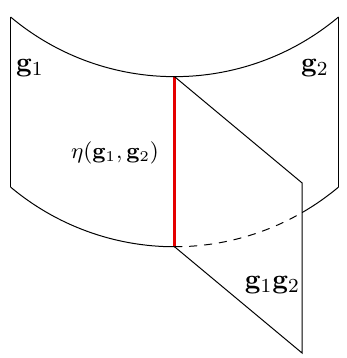
Figure 5 . A junction (in red) where three codimension-one 0-form symmetry defects of type g 1 ; g 2 ; g 1 g 2 2 G meet in codimension two, with one additional dimension suppressed in the (cid:12)gure. The junction can be modi(cid:12)ed by inserting codimension-two symmetry defects of one-form symmetry (cid:17) ( g 1 ; g 2 ) 2 A